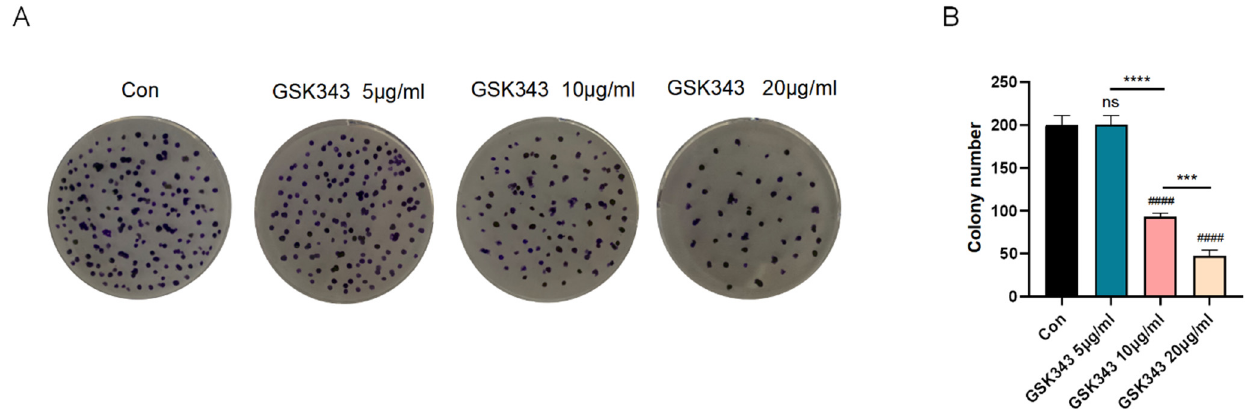
Figure 5. GSK343 alleviated A549 proliferation. ( A ) Representative images of colony formation and cell migration. ( B ) Inhibition of EZH2 significantly reduced colony formation ability in a concentration-dependent way. Data are presented as mean ± SD ( n = 3 per group) of the representative data from three independent experiments; *** p < 0.005, **** p < 0.001, #### p < 0.001, ns: no significance. The asterisk (*) demonstrates that the group is statistically different from the Con group.